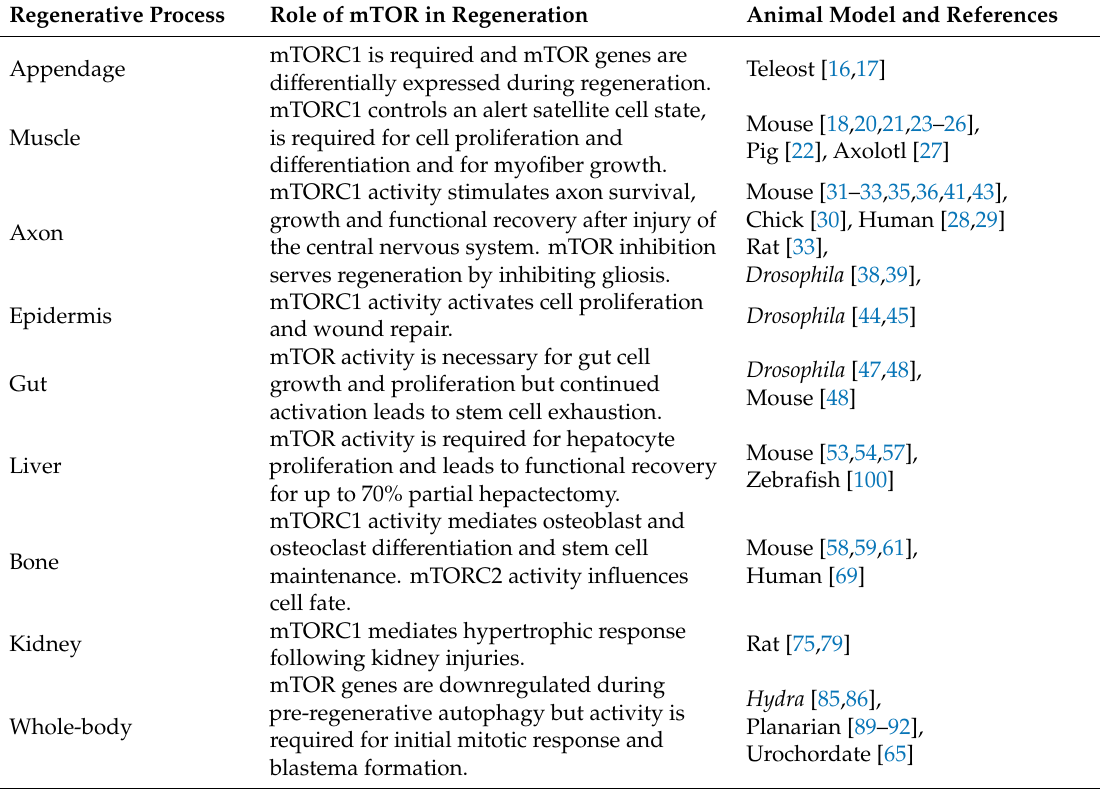
Table 2. Summary of the implication of the mTOR pathway in di ff erent regenerative